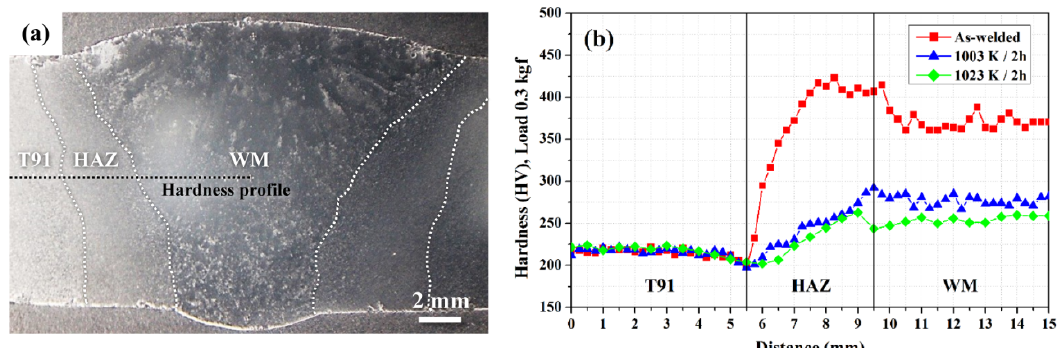
Figure 2. ( a ) Macroscopic appearance of a T91 weld in cross-sectional view, ( b ) microhardness profiles from the centerline of the WM across the heat-affected zone (HAZ) to the base metal (BM) in the as-welded and tempered conditions.